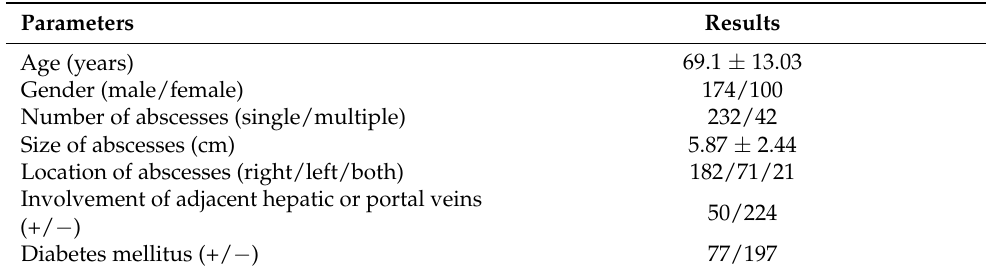
Table 1. Demographics and computed tomography findings of patients with pyogenic liver abscess caused by Klebsiella pneumoniae